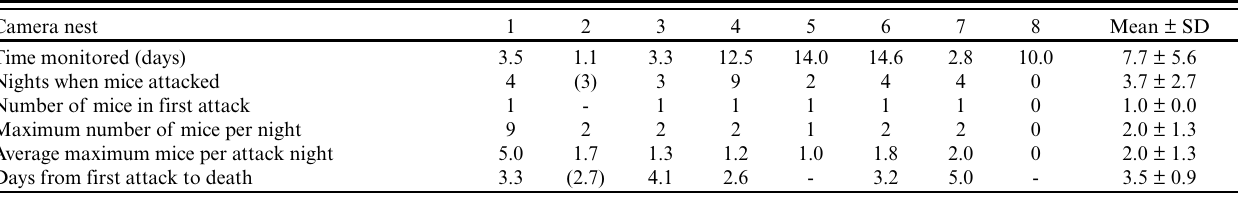
Table 1 . Summary of camera effort (61.8 days) monitoring eight Tristan Albatross ( Diomedea dabbenena ) chicks where six chicks die from mice wounds, one is attacked but recovers (nest 5), and one is not attacked (nest 8). For nest 2, the first attack by mice was not filmed (numbers in parentheses excluded from mean ± SD).